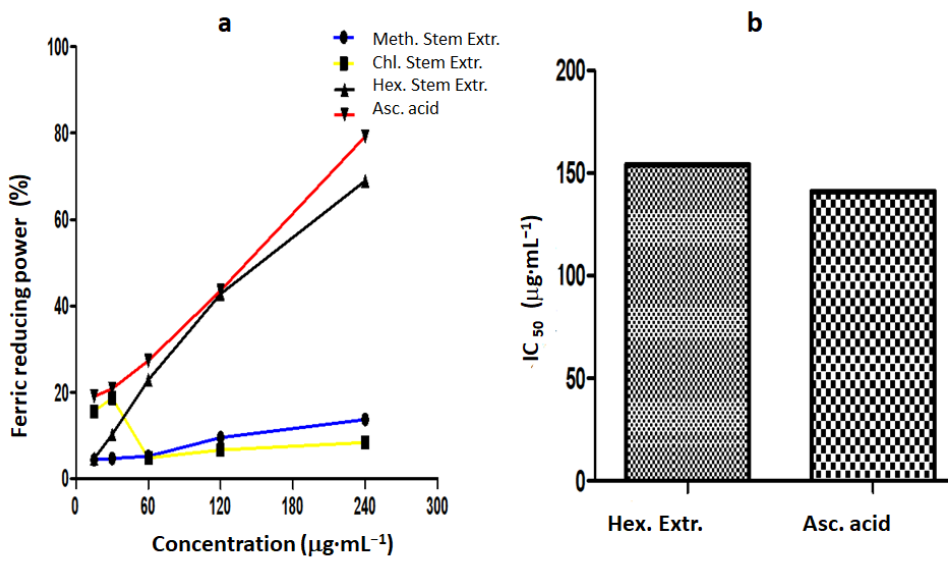
Figure 4. Comparison of ferric-reducing power in (%) of D. villosa stem-bark extract ( a ), IC 50 values for D. villosa stem ferric-reducing antioxidant potential ( b ). Chl. = Chloroform; Hex = Hexane, Meth. = Methanol; Extr. = Extract; Asc. Acid = Ascorbic acid.